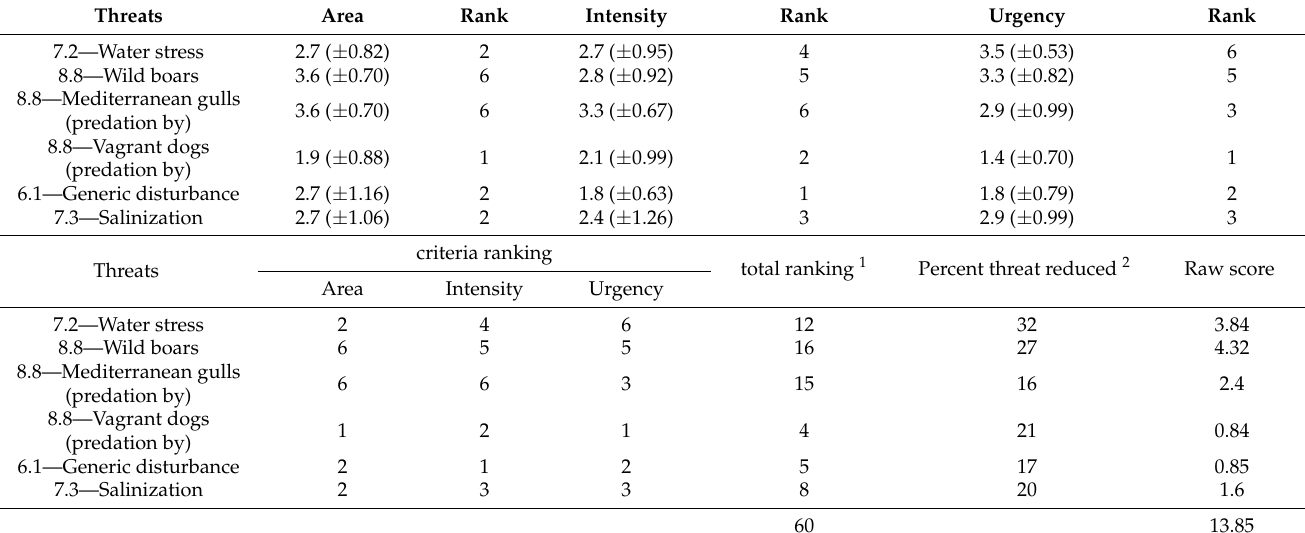
Table 2. Threat Reduction Assessment (TRA) procedure. Regime attributes of area, intensity and urgency and related ranks for the Threat Reduction Assessment and procedure to calculate the TRA-I index. (1): sum of ranking of area, intensity and urgency. (2): estimated percentage of threat mitigation over the assessment period. TRA-I index = Σ (raw score/total ranking) × 100 = 23.08%.